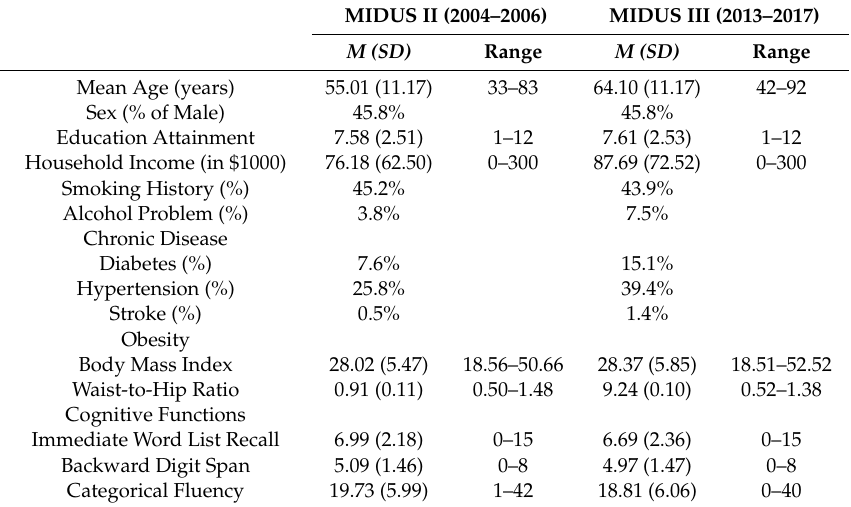
Table 1. Descriptive statistics of MIDUS II and MIDUS III